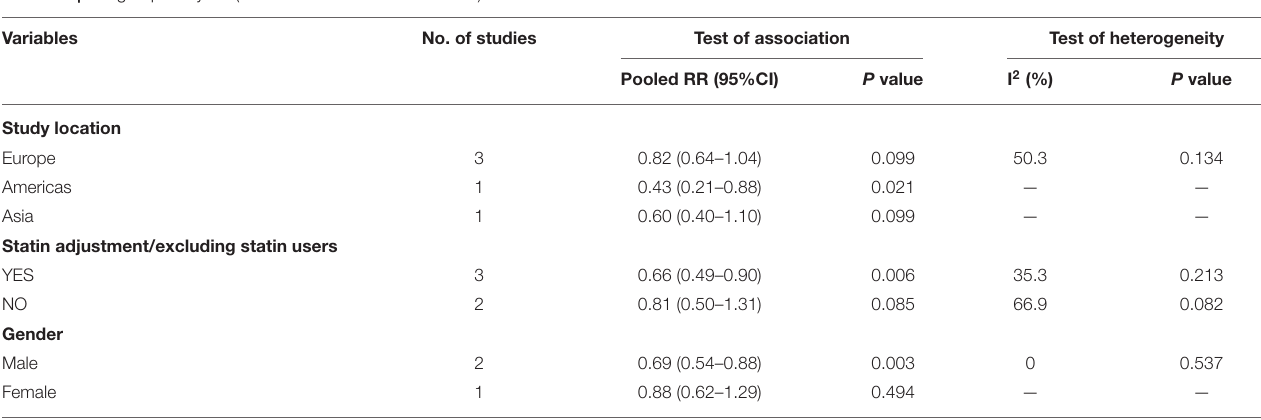
TABLE 3 | Subgroup analyses (serum LDL-C levels and PD